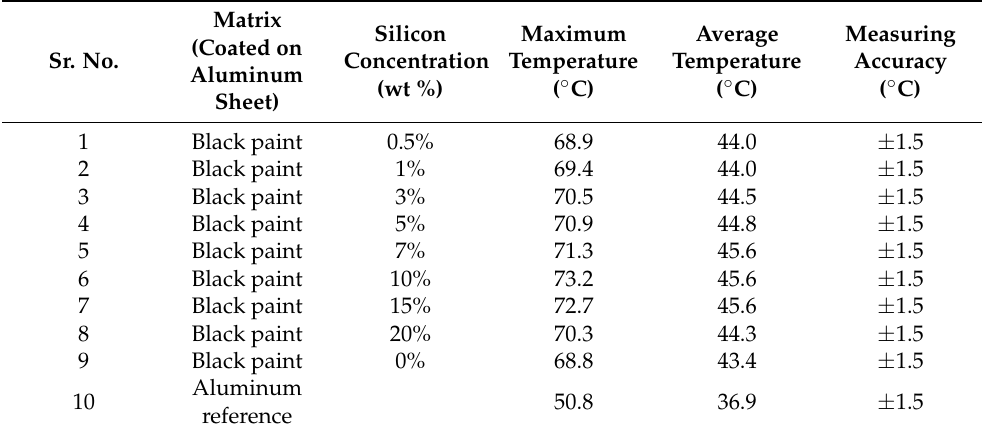
Table 3. Summary of the maximum observed temperature on the absorber surface vs. the concentra- tion of silicon in black